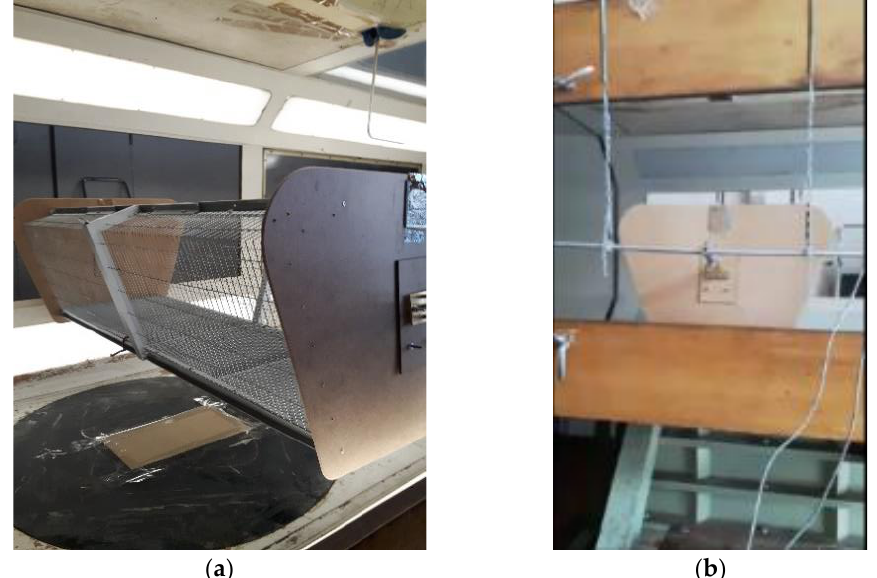
Figure 5. ( a ) The model installed in the wind tunnel, and ( b ) the model suspension.